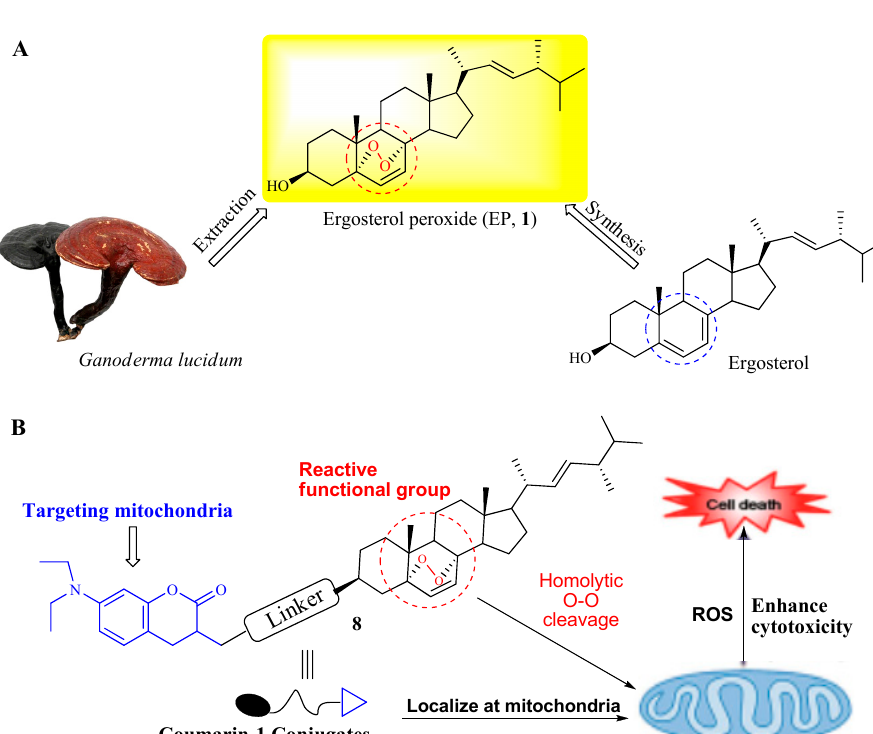
Figure 1. The chemical structures of compounds and design strategy. ( A ) The chemical structure and source of ergosterol peroxide ( 1 ). ( B ) The chemical structure of designed coumarin- 1 conjugates 8 , and the proposed mechanism of 8 for intracellular tracking and cancer-cell therapy.